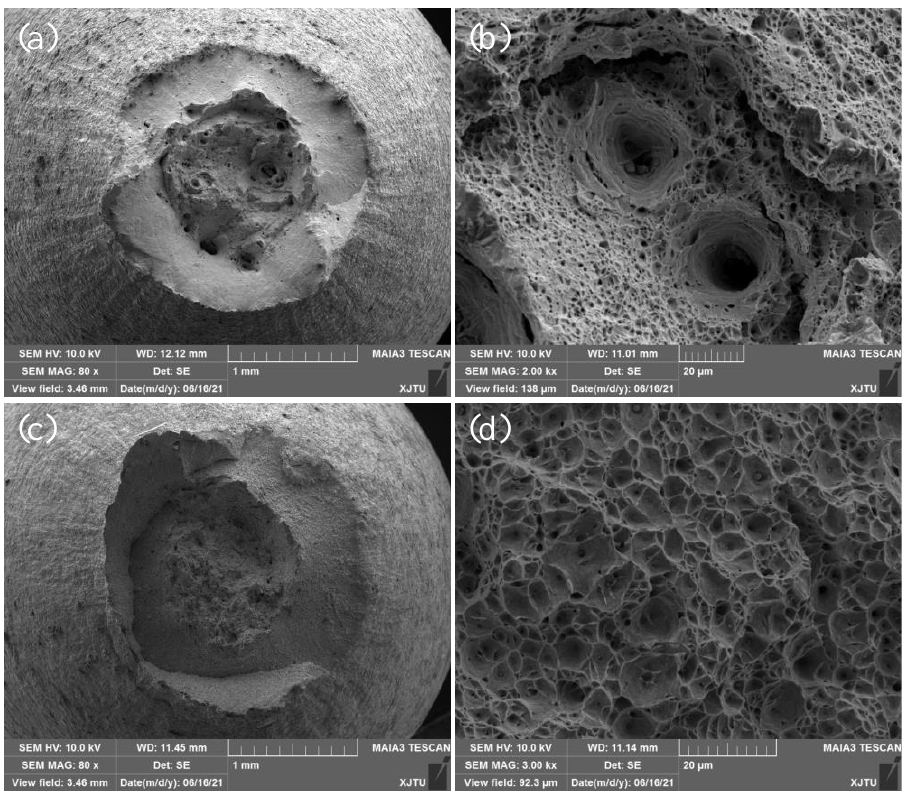
Figure 6. SEM images showing tensile fracture surfaces of ( a , b ) BM and ( c , d ) WM specimens at 550 ◦ C.